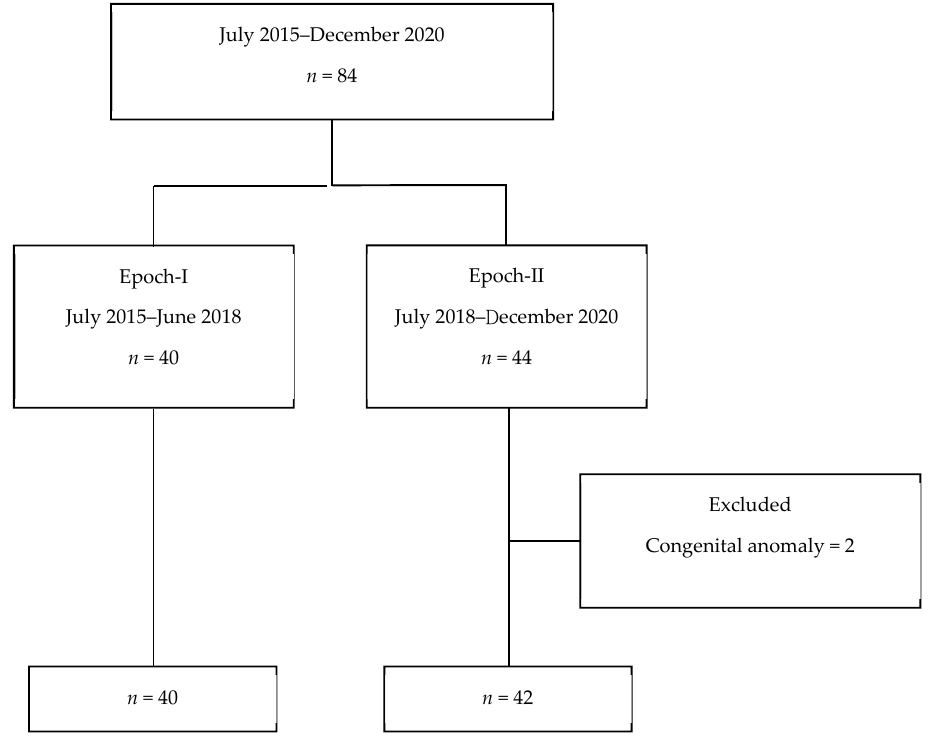
Figure 1. Flow chart of patient enrollment. n : case number.